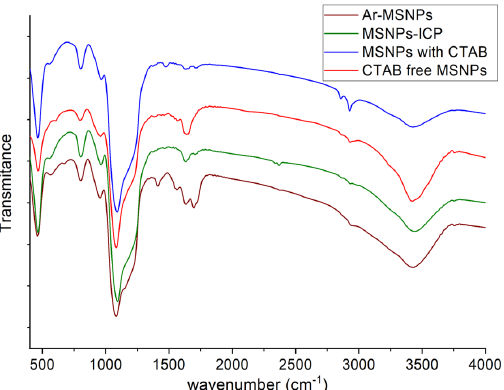
Figure 1. The FT ‐ IR spectrum of MSNPs (with CTAB), CTAB free MSNPs, MSNPs ‐ ICP, and Ar ‐ MSNPs.